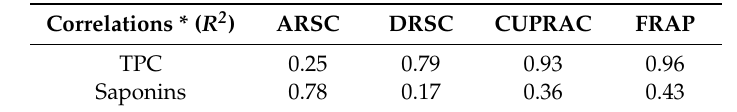
Table 2. Correlations between bioactive compounds and antioxidant capacity of carrot peel extracted by four various